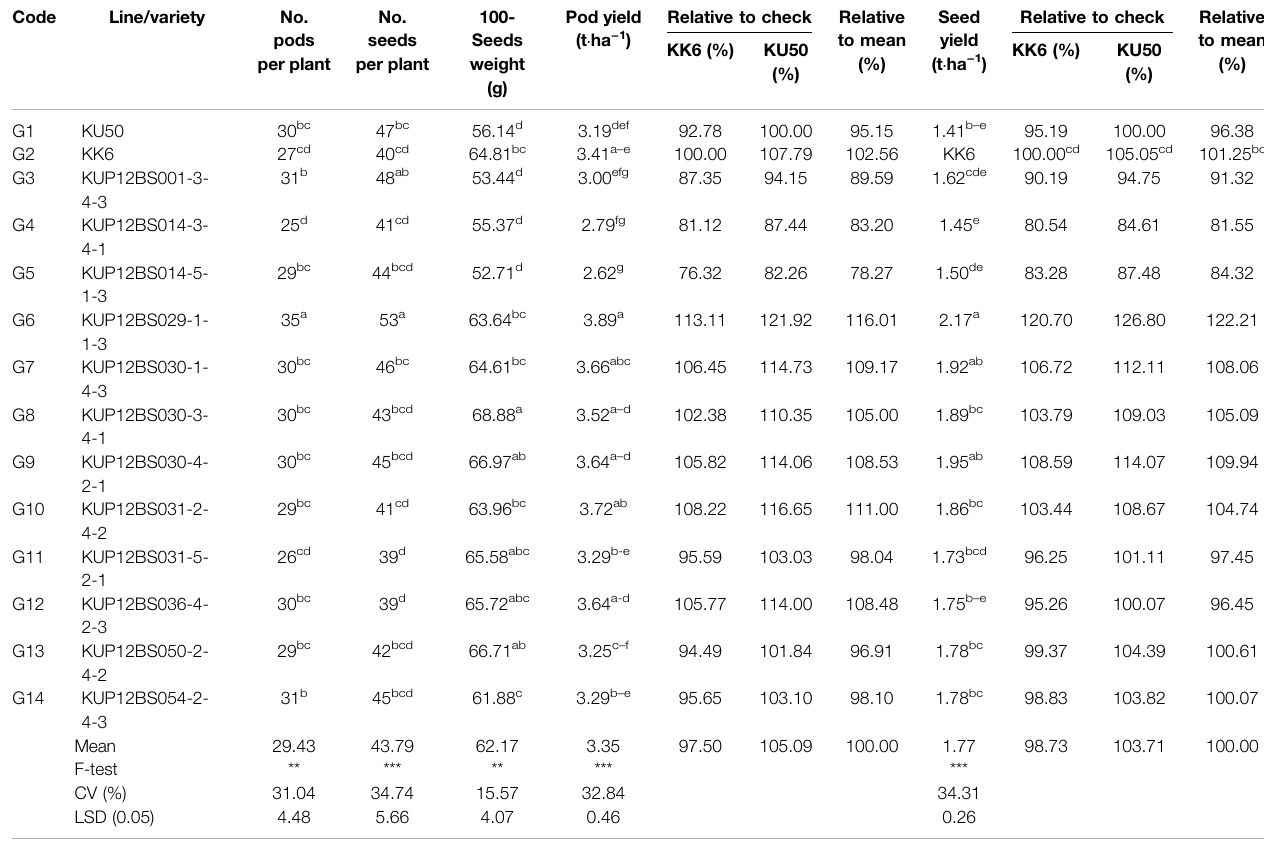
TABLE 3 | Yield and yield components of 12 peanut lines and 2 check